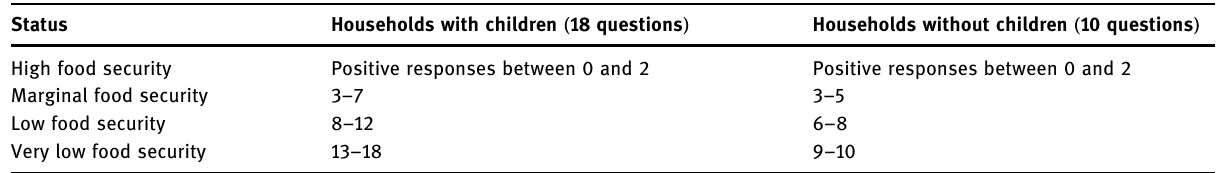
Table 1: USDA food security classi fi